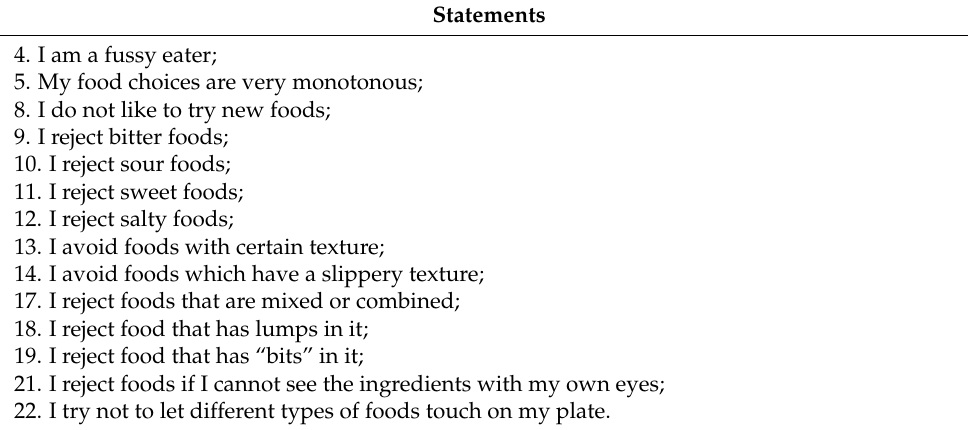
Table 1. The 14 statements used to divide parents into two groups based on parents’ fussy eating status (fussy or not).